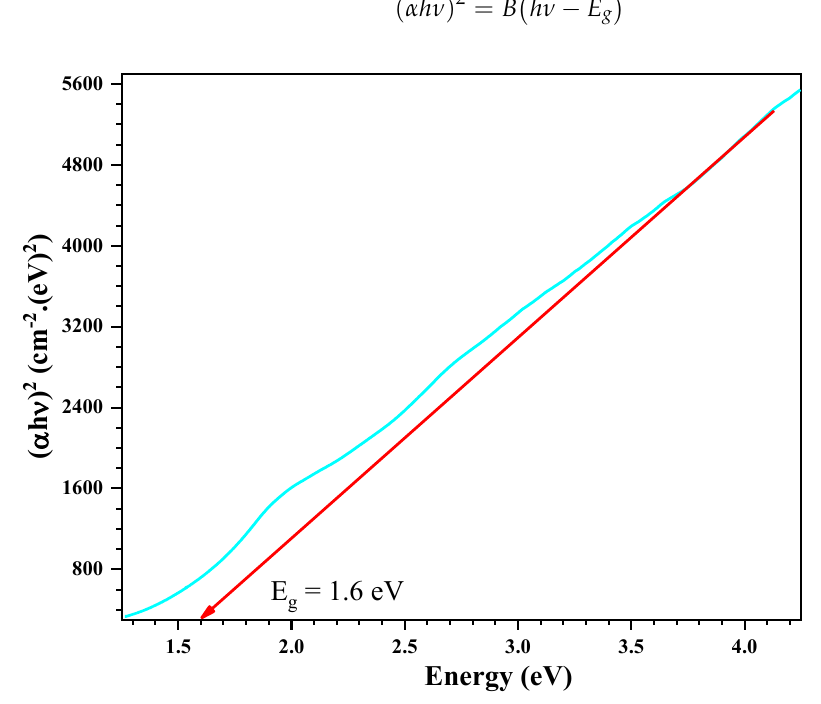
Figure 7. Tauc plot of prepared Se NPs.